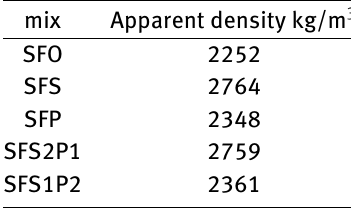
Figure 5: Impact resistance device